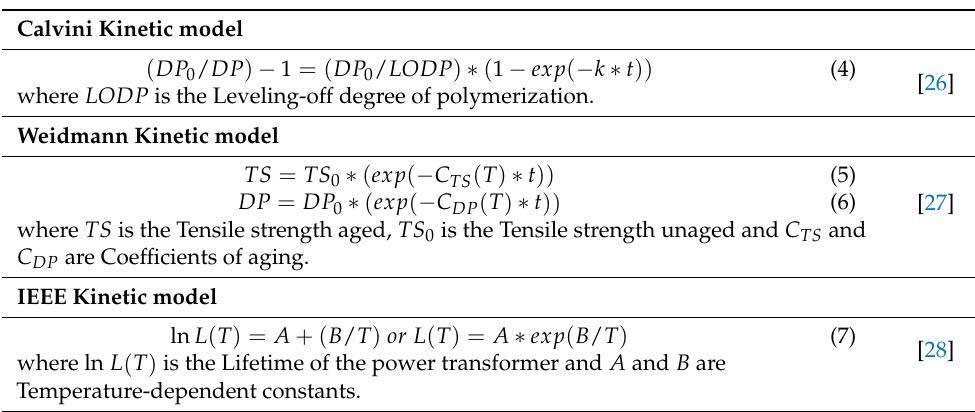
Table 1. Cont. Calvini Kinetic model